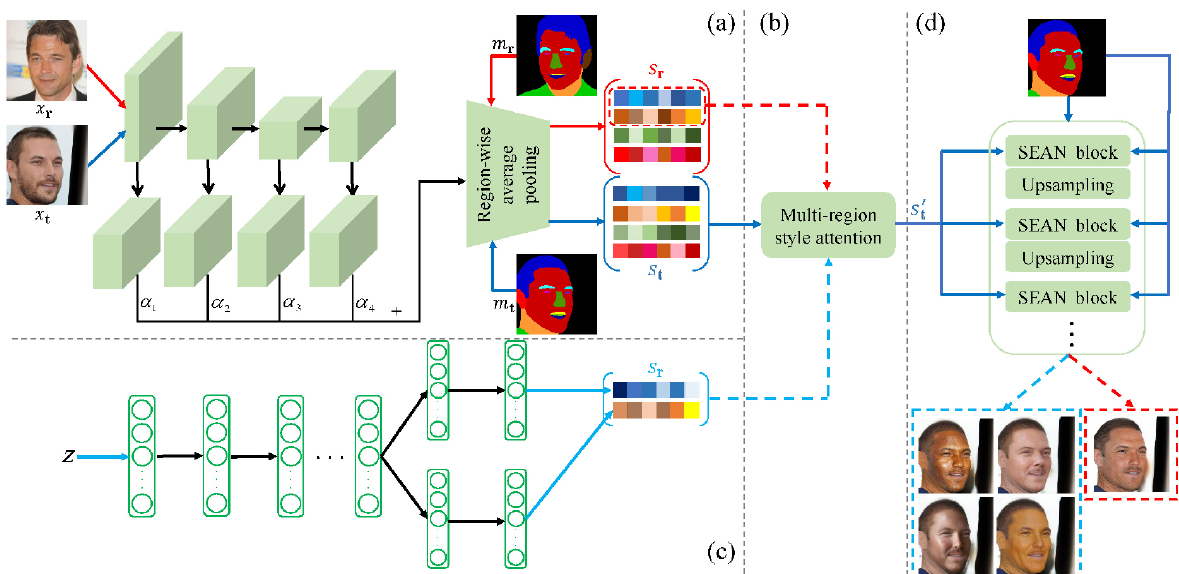
Fig. 3 Framework. (a) Multi-level feature fusion part of the encoder. (b) Multi-region style attention module. (c) An example style mapping network, in which the mapping network generates styles for skin and nose simultaneously; multi-modal results are shown in (d). (d) SEAN generator with results of (a) and